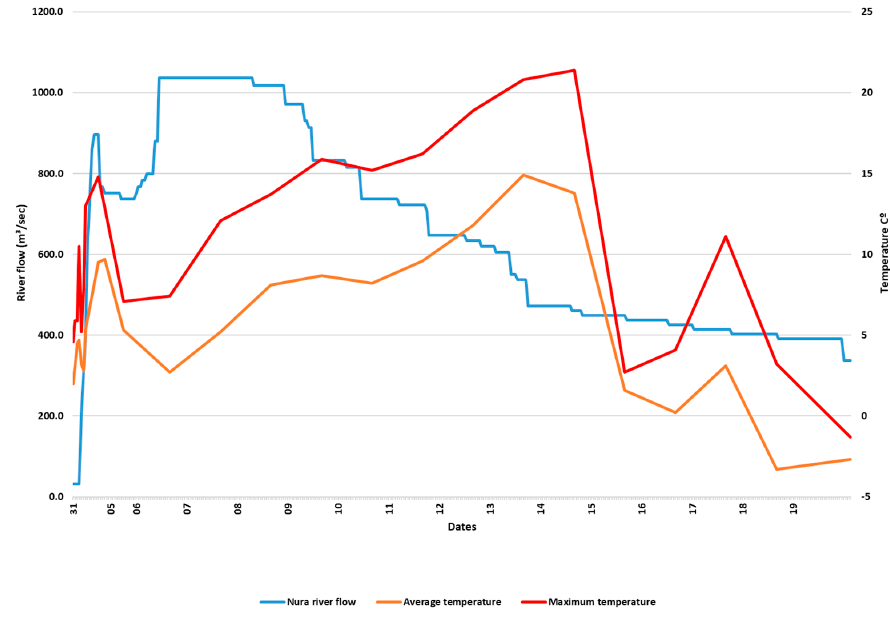
Figure 16. The course of the hydrograph of the spring flood in 2019 along the site of the Preobrazhenskiy waterwork; the course of maximum and average daily air temperatures at the weather station in Astana from 30 March to 19 April 2019.